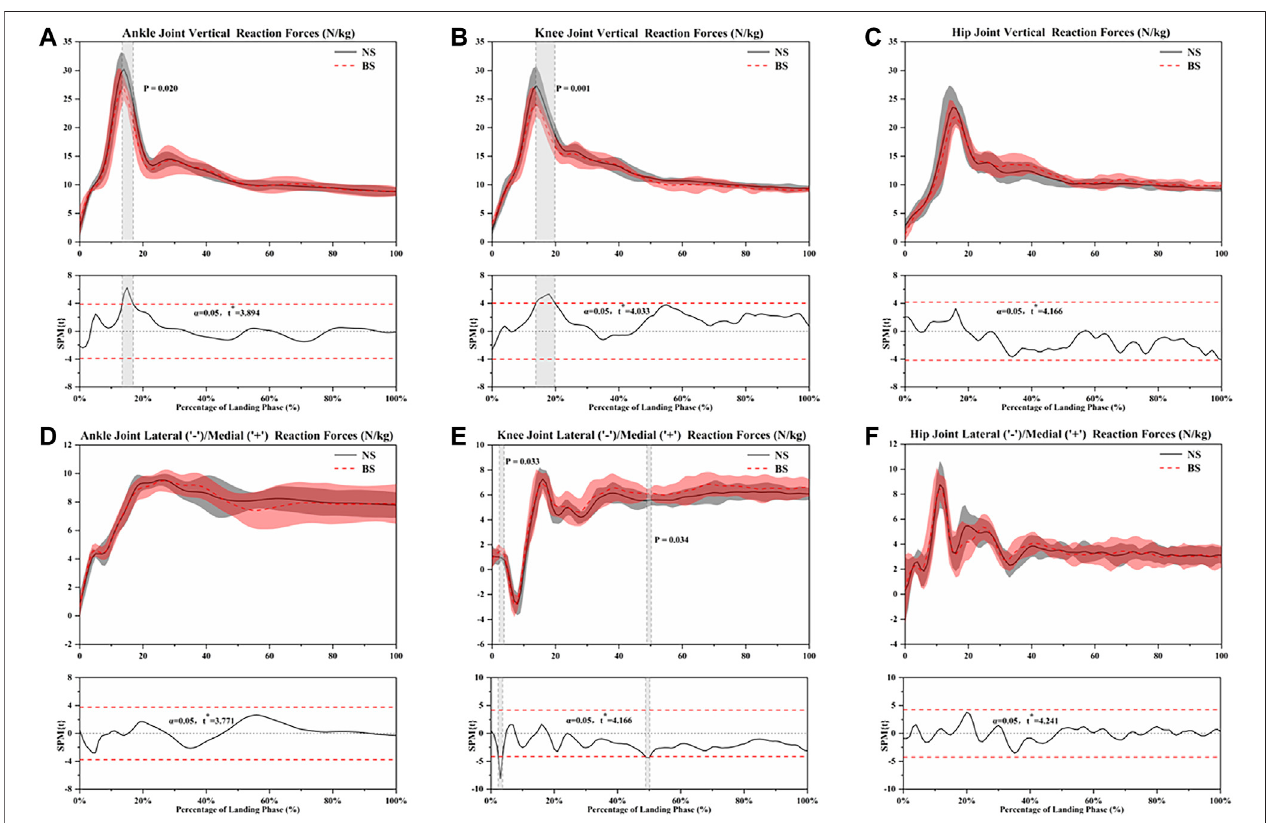
FIGURE 4 | The Statistical Parametric Mapping (SPM) results between NS and BS during single-leg landing task, depicting the mean joint vertical reaction forces, mean joint lateral, and medial reaction force. Grey shaded areas indicate that there are signi fi cant differences ( p < 0.05) between NS and BS during the landing phase.